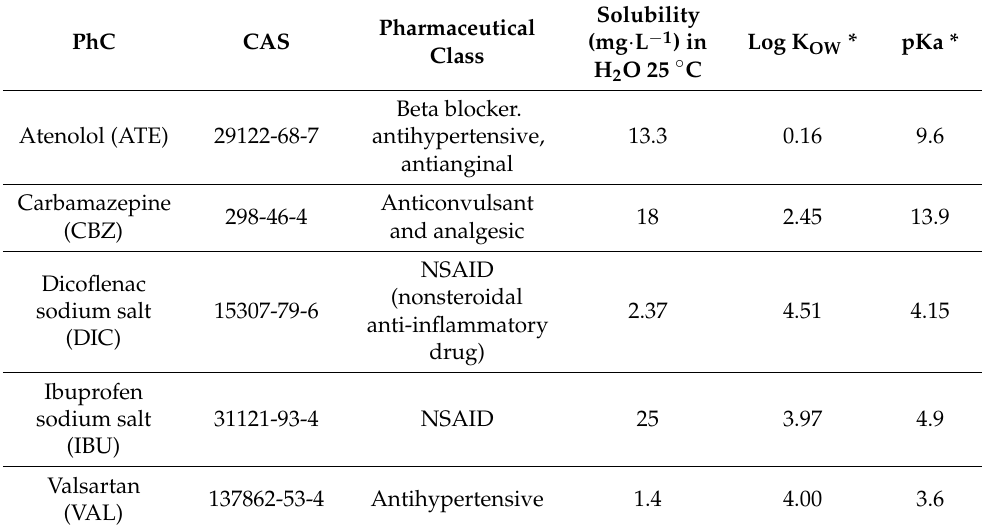
Table 2. Identifiers, pharmaceutical class and physico-chemical characteristics of the target PhCs.